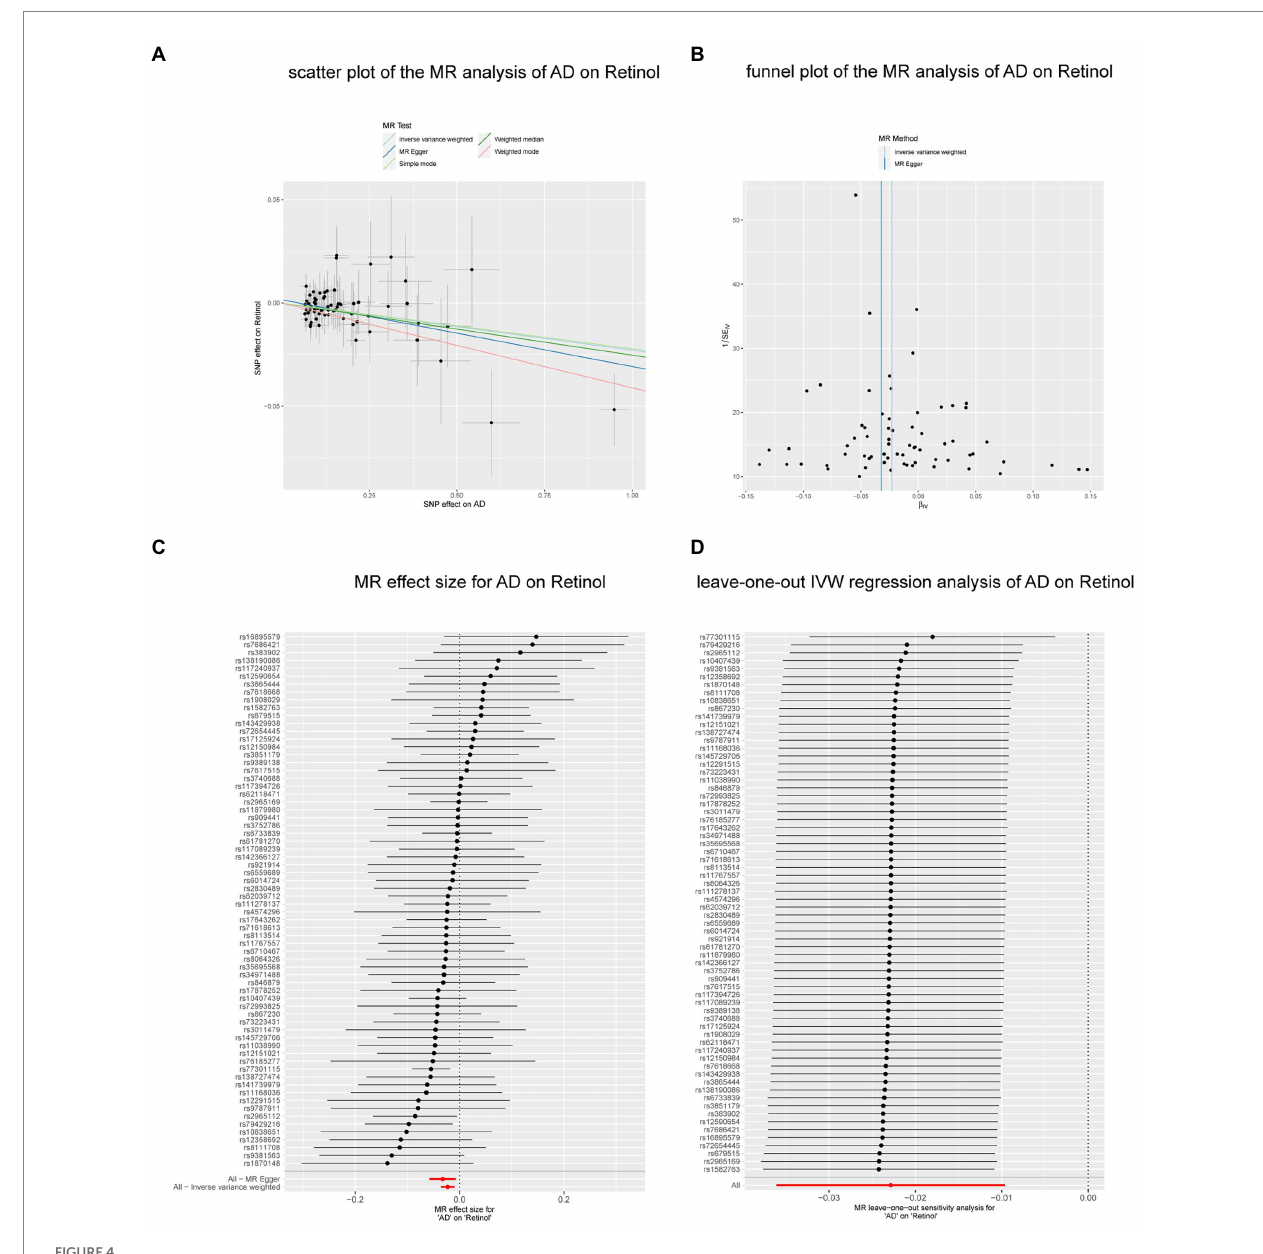
FIGURE 4 The causal effect of AD on retinol. (A) Scatter plot of the MR analysis of AD on retinol. (B) Funnel plot of the MR analysis of AD on retinol. (C) MR effect size for AD on retinol. (D) Leave-on -out IVW regression analysis of AD on retinol. Abbreviations: MR: Mendelian randomization; AD, Alzheimer’ s disease; IVW, inverse variance